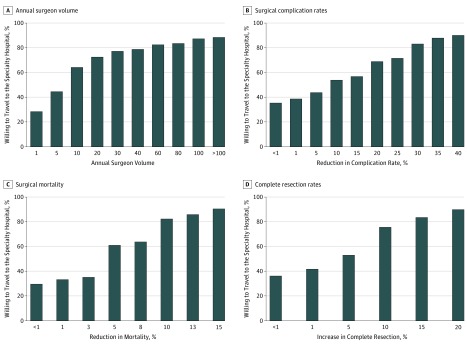
Thresholds to TravelA separate graph is shown for 4 of the 6 quality and safety indicators. Each bar represents the total percentage of who would travel at any given threshold (and therefore includes respondents who indicated a specific threshold or any smaller margin).